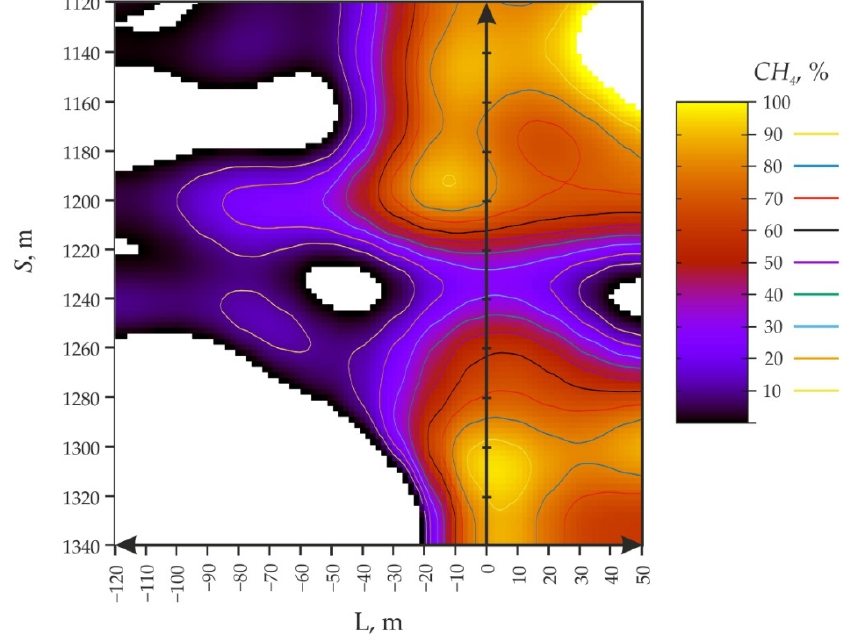
Figure 4. Spatial distribution of methane release dynamics in well No. 4.